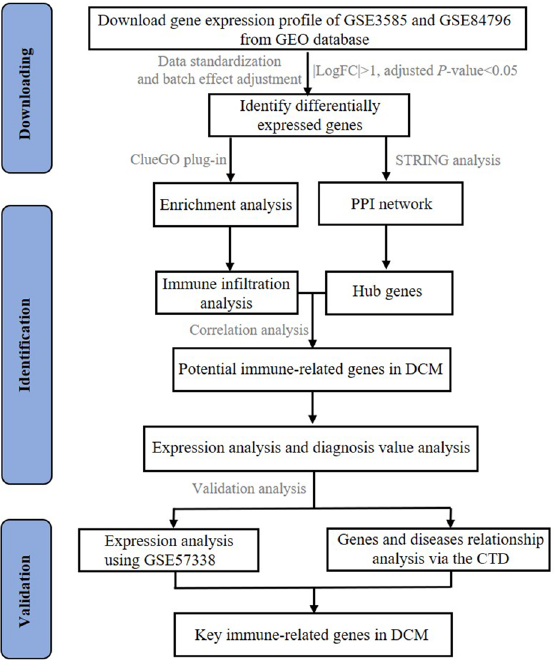
Figure 1. Flowchart of data analysis in this study. GEO: Gene Expression Omnibus; PPI: protein–protein interaction; DCM: dilated cardiomyopathy; CTD: comparative toxicogenomics database.